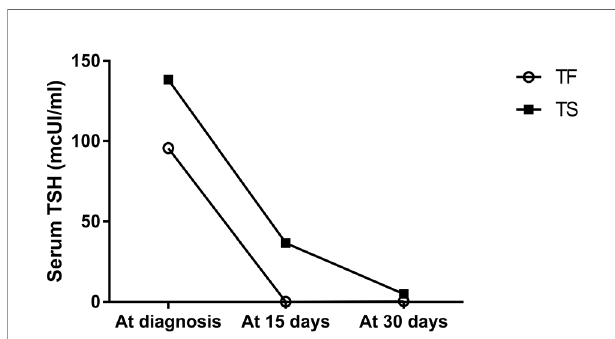
FIGURE 1 | Serum TSH change using Tirosint and Tifactor in the fi rst month of life in newborns affected by